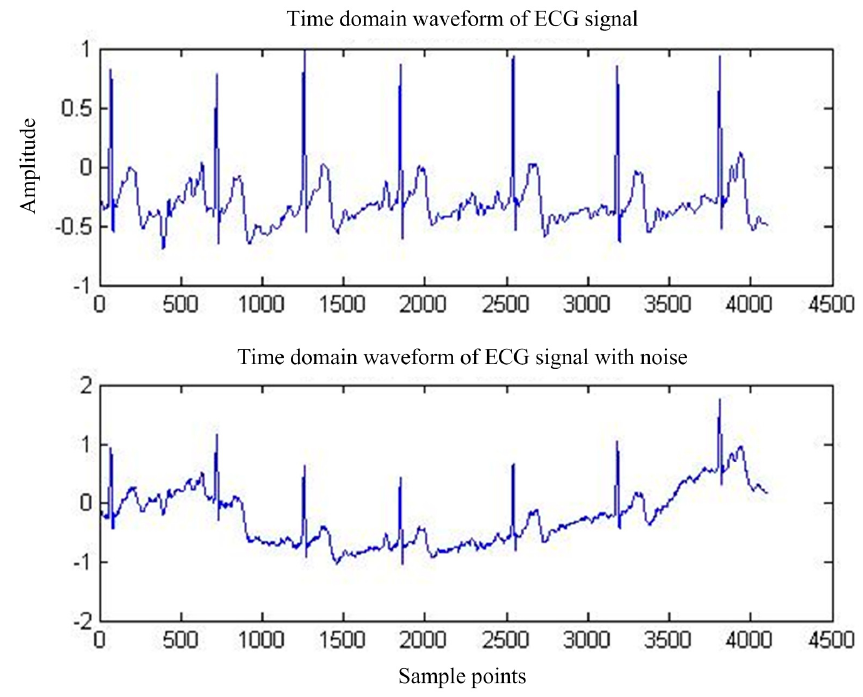
Figure 17. ECG waveforms before and after interference with BW.